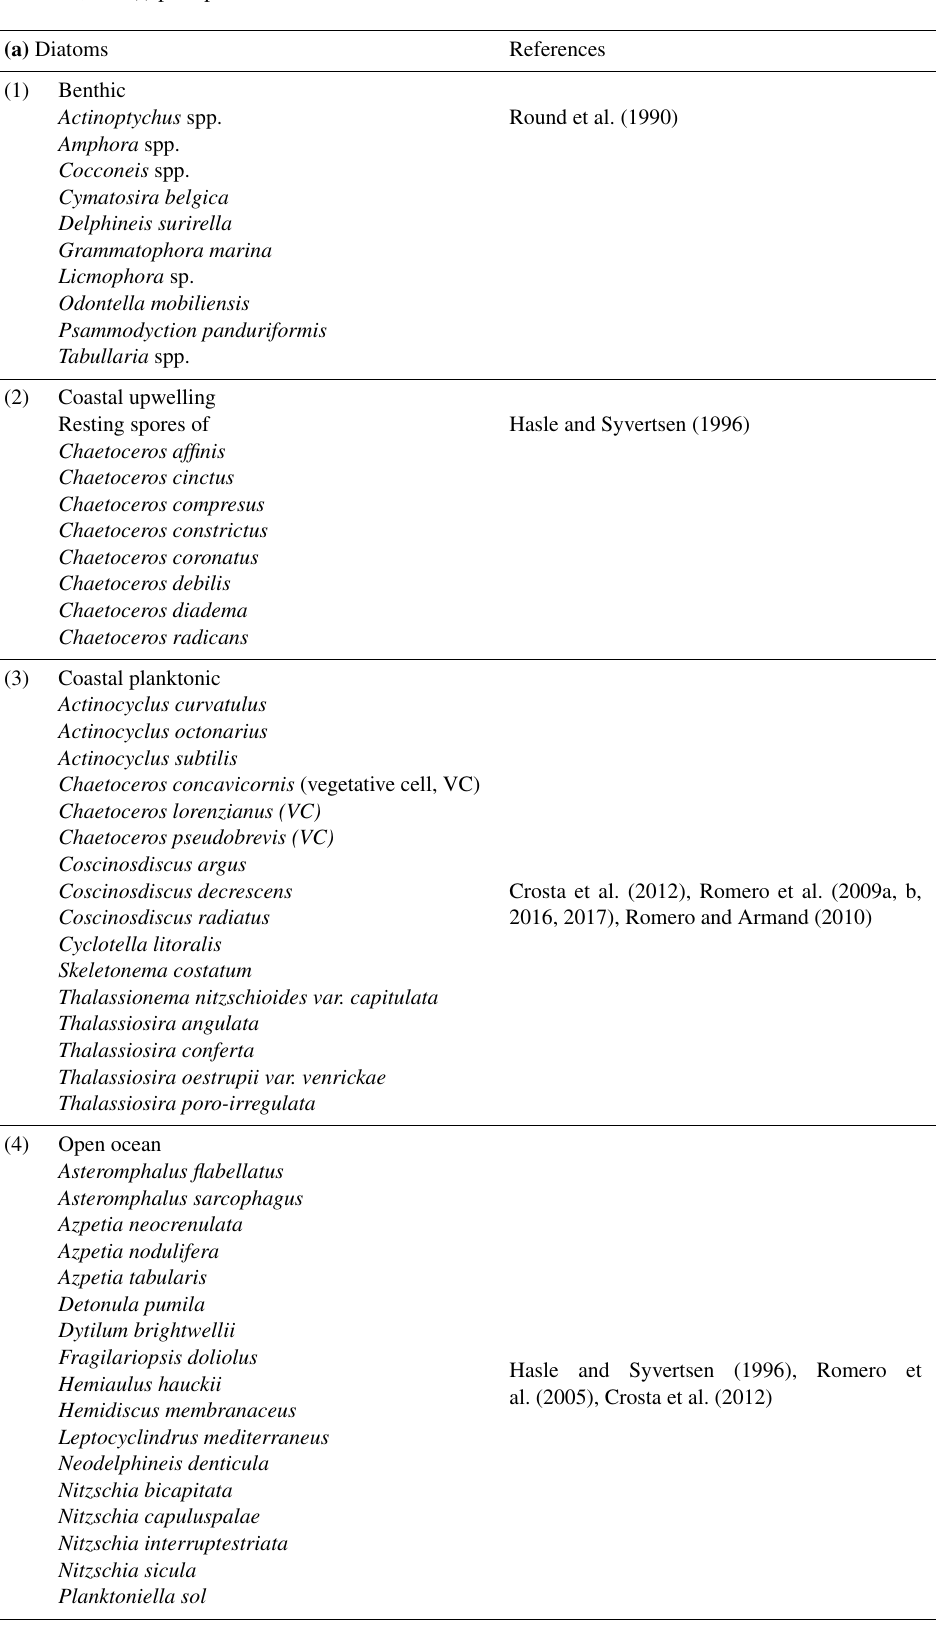
Table 5. Species composition of the assemblage of (a) diatoms, (b) coccolithophores, (c) calcareous and (d) organic dinoflagellate cysts, (e) planktonic foraminifera, and (f) pteropods at site CBeu between June 2003 and March